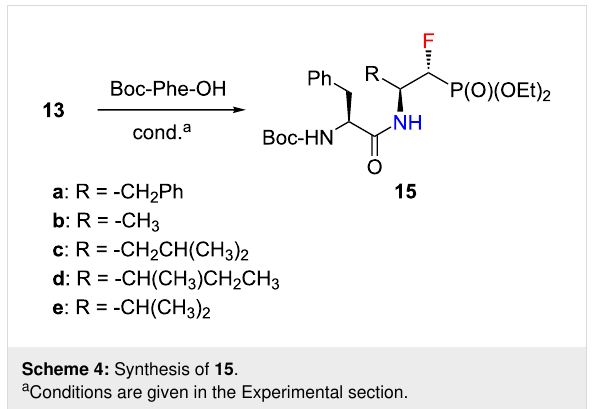
Moreover, amines 13 were used as substrates in the